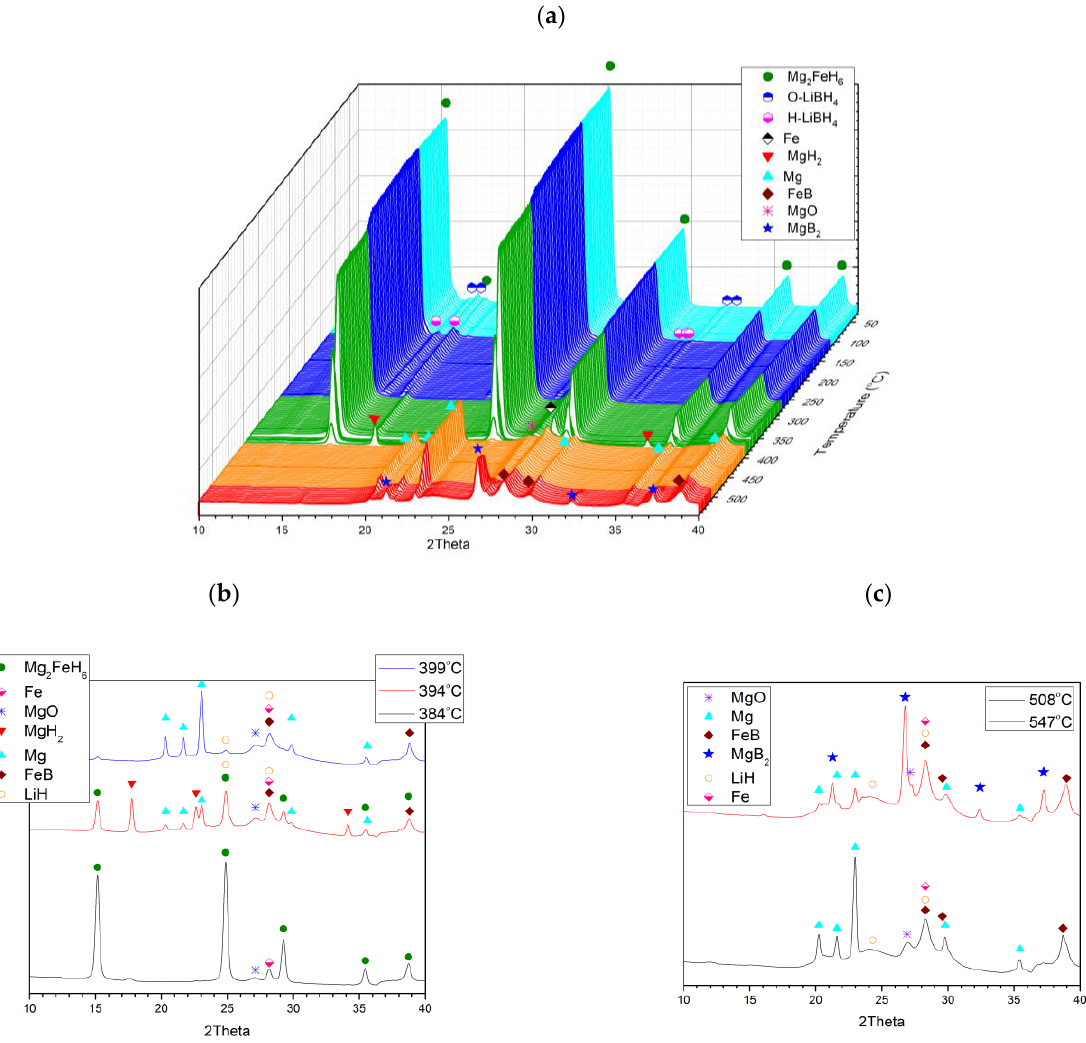
Figure 7. ( a ) In situ synchrotron XRD patterns of 2LiBH 4 – Mg 2 FeH 6 dissociation (heat rate 5 °C/min) in a 10-bar hydrogen atmosphere. Measured at Lund ( λ = 0.99242 Å). ( b ) Reactions A and B at different temperatures. ( c ) Dissociation of LiBH 4 with concomitant consumption of magnesium to form MgB 2 (the C substep).